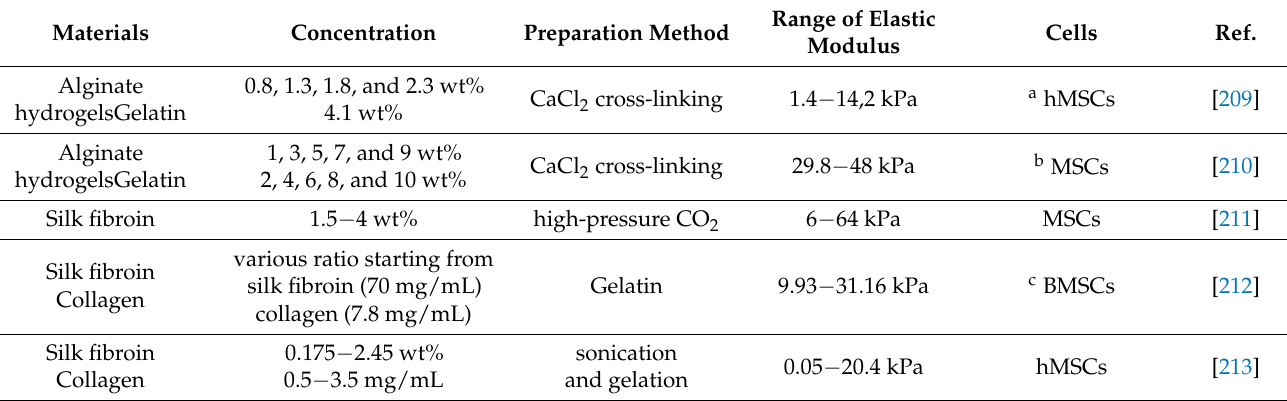
Table 7. Different approaches are utilized for the modulation of hydrogels’ mechanical